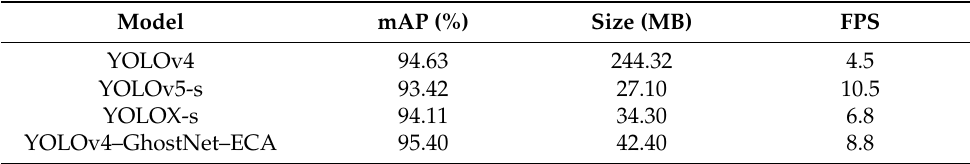
Table 4. Results of edge-end device operation.